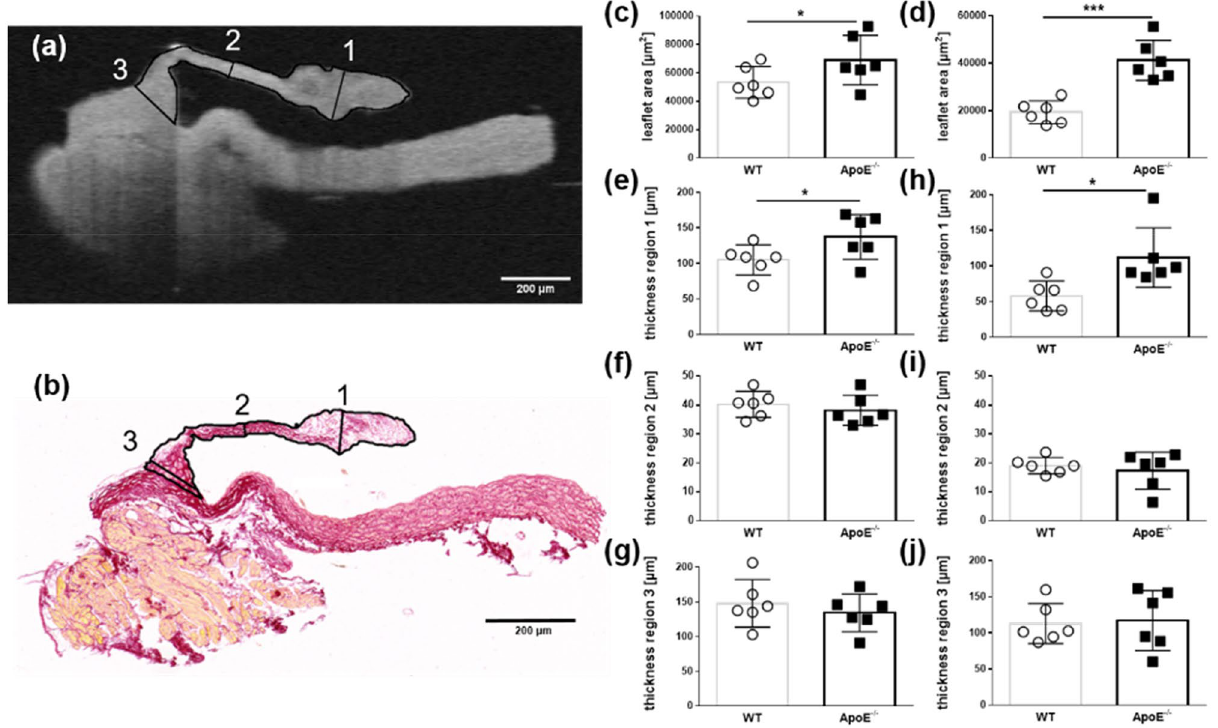
Figure 1. Quantification of the leaflet area and thickness in WT and ApoE −/− mice ( n = 6). ( a ) OCT scan of a representative acoronary aortic leaflet showing the allocation of the grid pattern to define regions 1, 2, and 3. ( b ) Histological section of the same representative acoronary aortic valve leaflet and corresponding regions. ( c ) The mean leaflet area and ( e–f ) thickness of the acoronary aortic valve leaflets from the OCT scans. ( d ) The mean leaflet area and ( h–j ) thickness of the acoronary aortic valve leaflets from histological sections. MW ± SD; * P ≤ 0.05, ** P ≤ 0.01, and *** P ≤